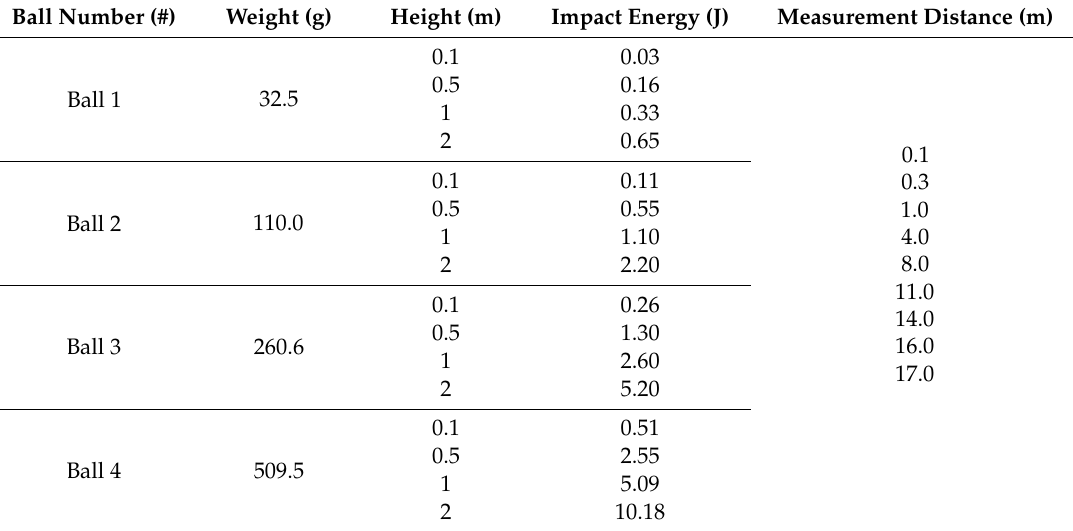
Table 2. Experimental cases by ball and dropping height.